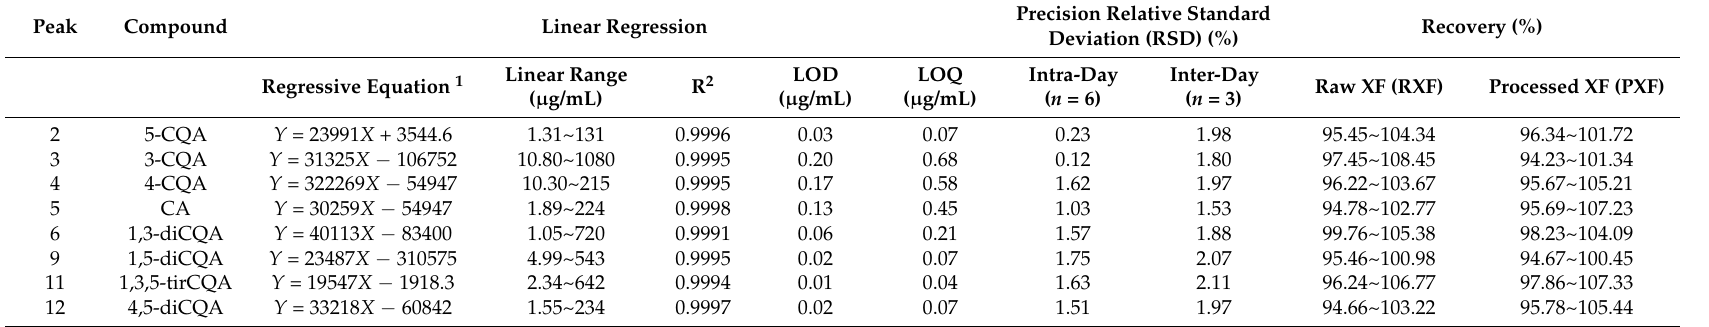
Table 1. Linear range, regression equation, R 2 , and limit of detection (LoD) precision of eight